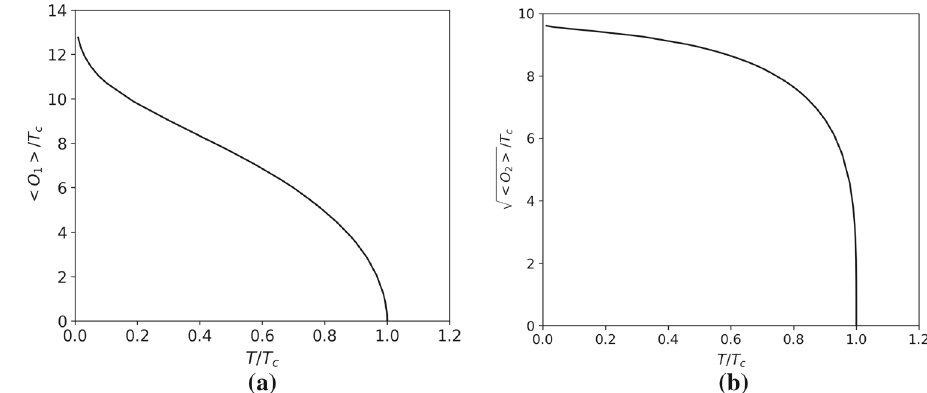
as T → T c = 0 . 113 μ and